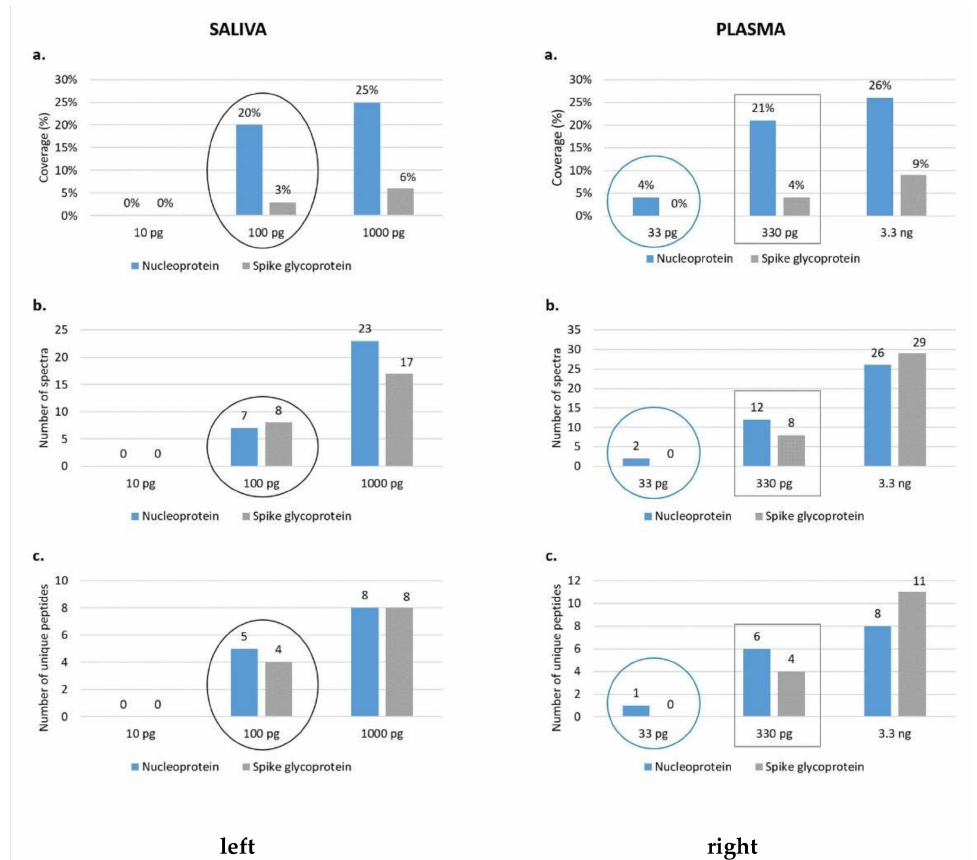
Figure 5. Correlation between the amount of purified viral proteins spiked into saliva and plasma and sequence coverage (a), number of spectra (b) and unique peptides (c). Bar charts showing the correlation between the amount of purified SARS-CoV-2 proteins (S1, S2, RBD and N) spiked into saliva ( on the left ) and plasma ( on the right ) after digestion and sequence coverage (a), number of spectra (b) or unique peptides (c) identified for the nucleoprotein and the spike glycoprotein. The limit of characterisation is shown in a black circle for both proteins in saliva, while it is shown in a blue circle for the nucleoprotein and in a grey rectangle for the spike glycoprotein in